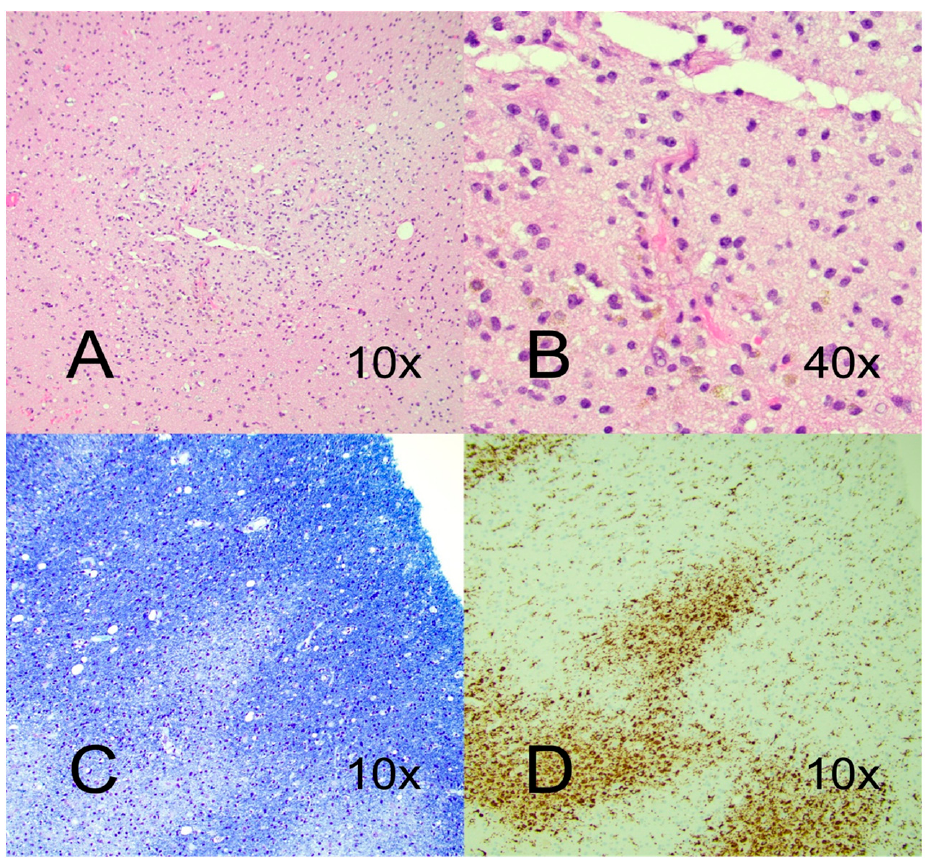
Figure 3. Hematoxylin and eosin (HE)—stained section from right temporal lobe biopsy demonstrated perivascular infiltrates of macrophages and small CD3+ lymphocytes ( A ) with hemosiderin deposits as a sign of former hemorrhage ( B ). Luxol fast blue stain showed perivascular demyelination ( C ), and CD68+ stained macrophage infiltrates ( D ).